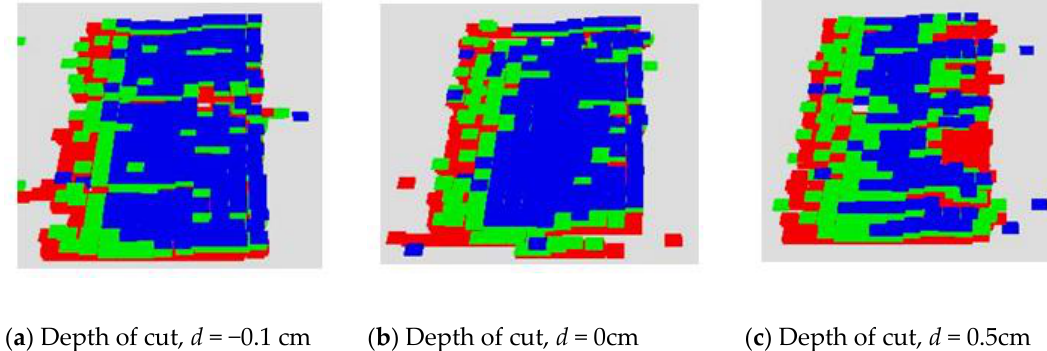
Figure 16. Composite images of the grinding results at different depth of cut values.